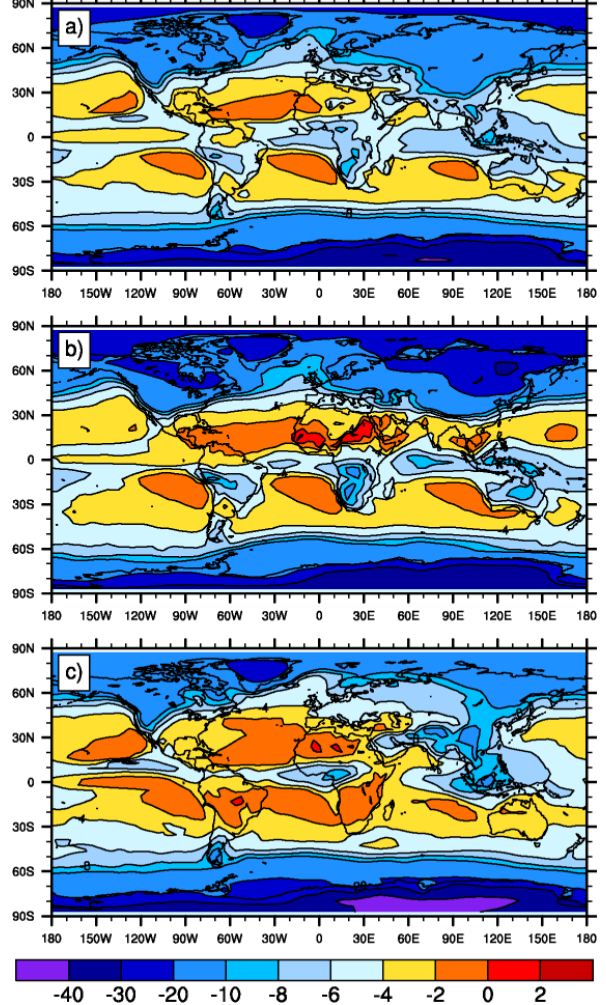
Fig. 1. Global distribution of δ 18 O precip (‰) for the control run: (a) annual mean, (b) December–January–February (DJF) season, and (c) June–July–August (JJA) season.